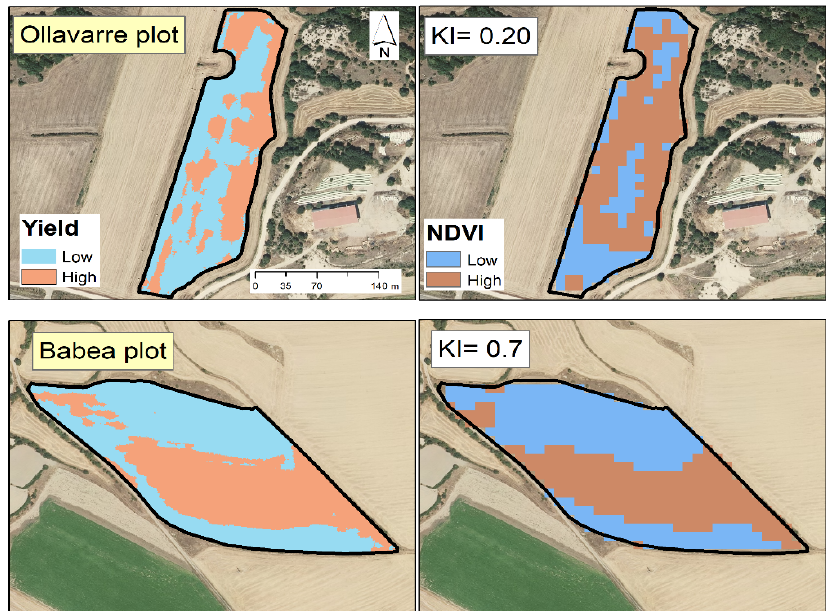
Figure 6. NDVI and yield classified maps, and agreement between them according to Kappa Index (KI). Plot without concordance ( top ) and plot with concordance ( bottom ). Table 4. Values of Kappa Index between yield map and NDVI images of different dates in 2019 for 13 wheat plots. In bold is the first date when a moderate agreement is achieved.